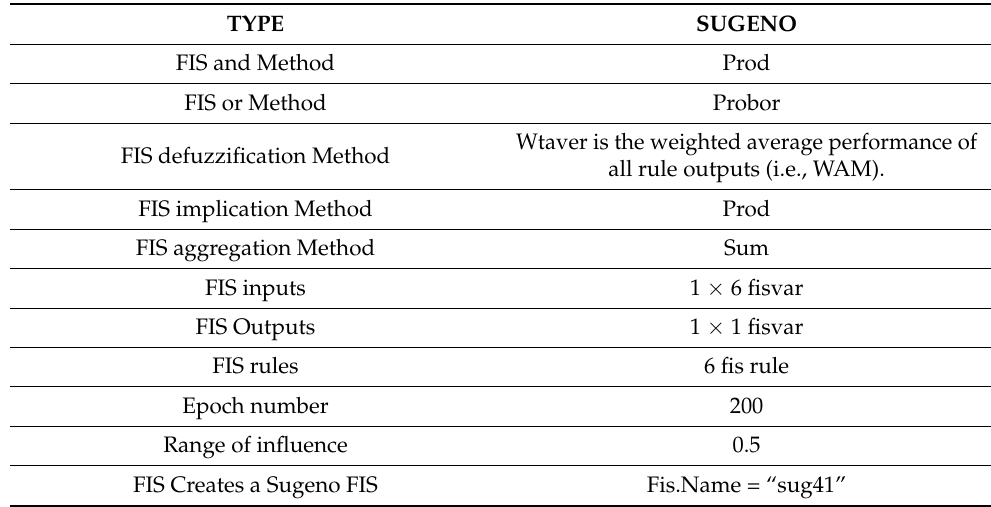
Figure 3. The five layers-based structure of the ANFIS ( a ) and the defuzzification WAM internal structure ( b ). Table 2. The training parameters of the ANFIS